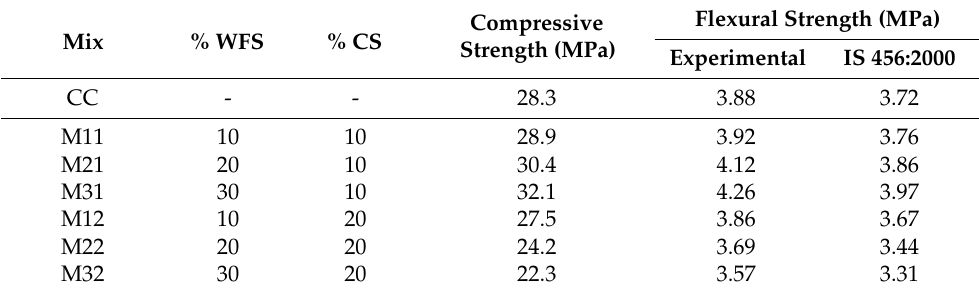
Table 9. Comparison of experimental and predicted values of flexural